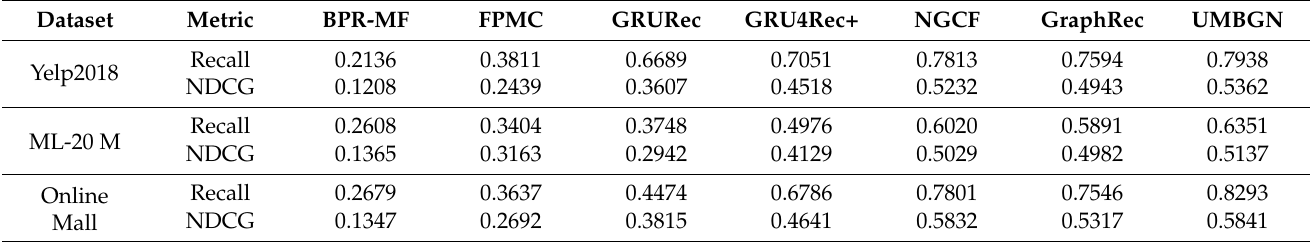
Table 2. Performance comparison of all methods in terms of Recall@10 and NDCG@10 on all